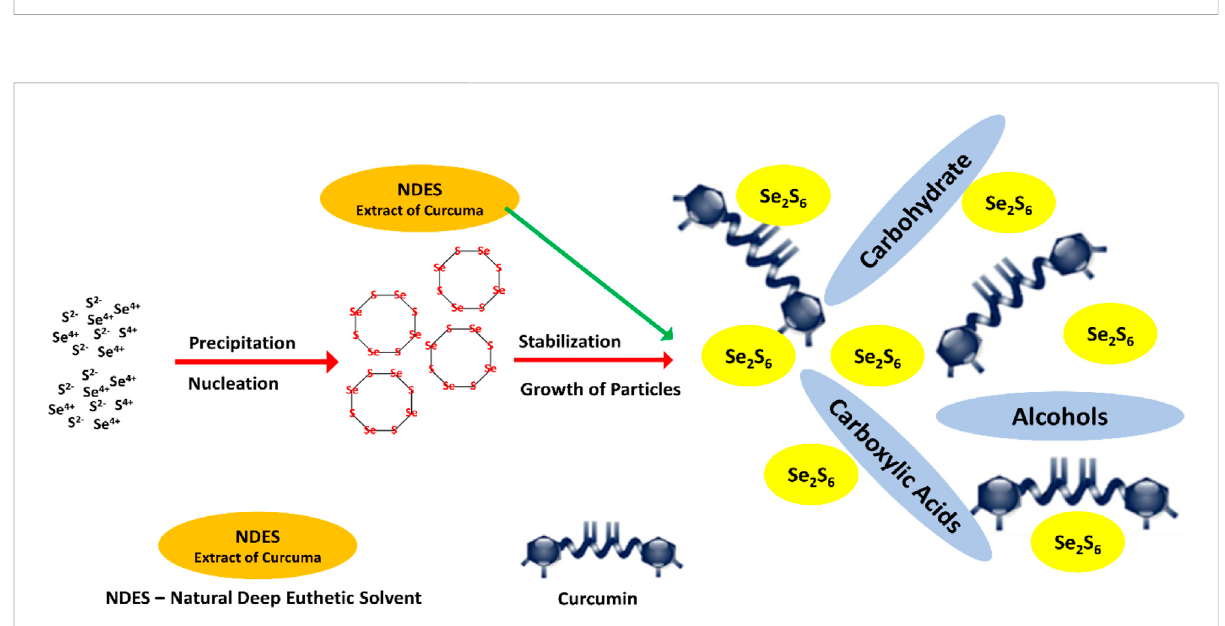
FIGURE 4 Synthesis of Se sul fi de nanoparticles in NDES extract of curcuma (D ł ugosz et al.,